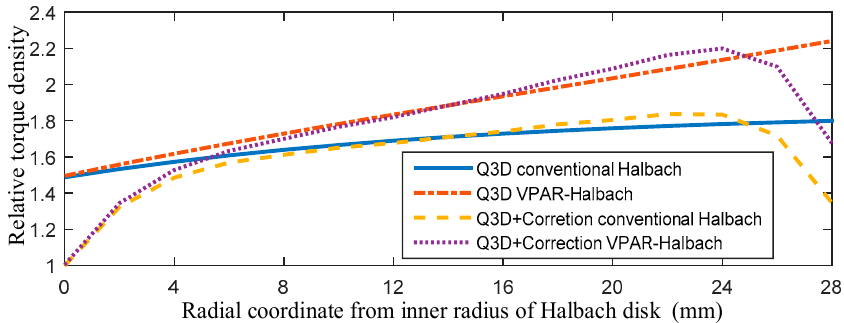
Figure 10. Comparison of relative torque density along the radial coordinates.